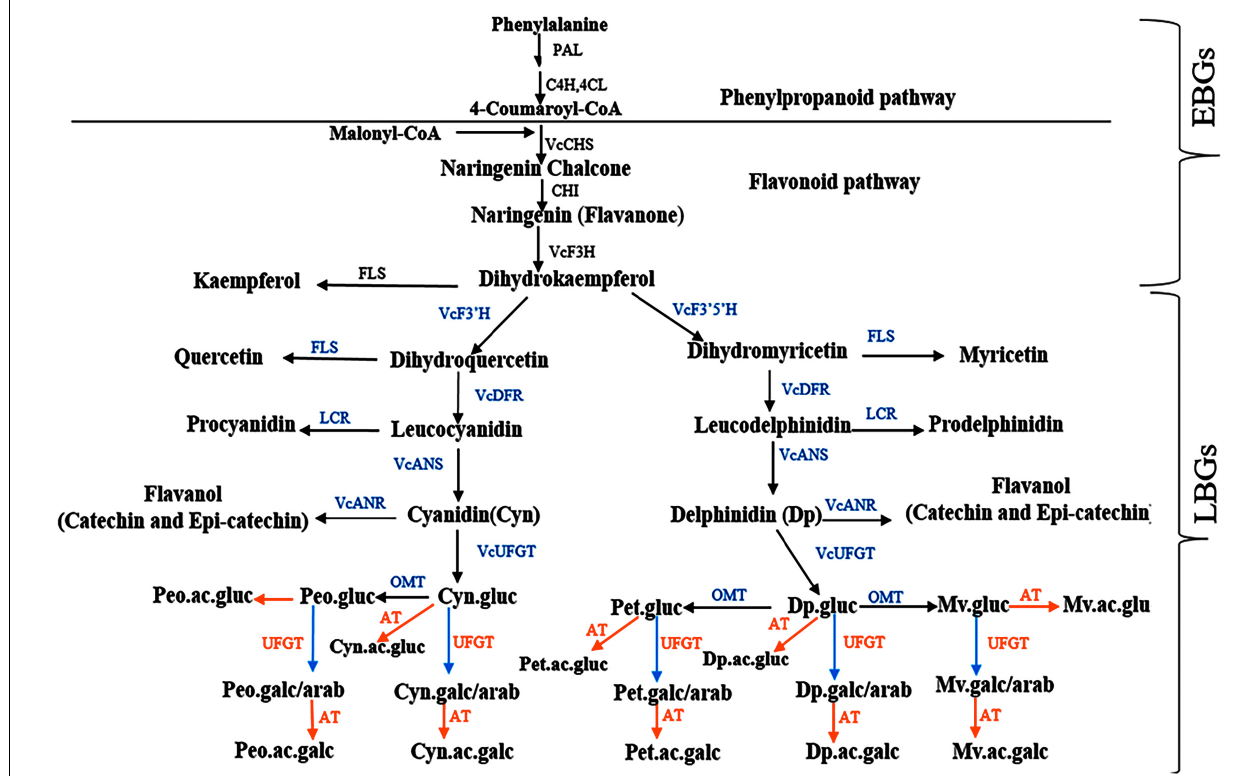
FIGURE 9 | A schematic representation of anthocyanin pathway in blueberry with slight modification from bilberry as described in Jaakola et al. (2002). Enzyme abbreviations: C4H, Cinnamate 4-hydroxylase4; 4CL, 4-coumaroyl:CoA ligase; CHI, chalcone isomerase; F3 (cid:48) H, flavonoid 3 (cid:48) hydroxylase; F3 (cid:48) 5 (cid:48) H, flavonoid 3 (cid:48) 5 (cid:48) hydroxylase; LCR, leucoanthocyanidin reductase; UFGT, UDP Glc-flavonoid 3- O -glucosyl transferase; OMT,O-methyltransferase. Sugar and anthocyanidins abbreviations: gluc, glucoside; arab, arabinoside; galc, galactoside; Mv, malvidin; Pet, petunidin; and Peo, peonidin. Pathway genes: EBGs, early biosynthesis genes; LBGs, late biosynthesis